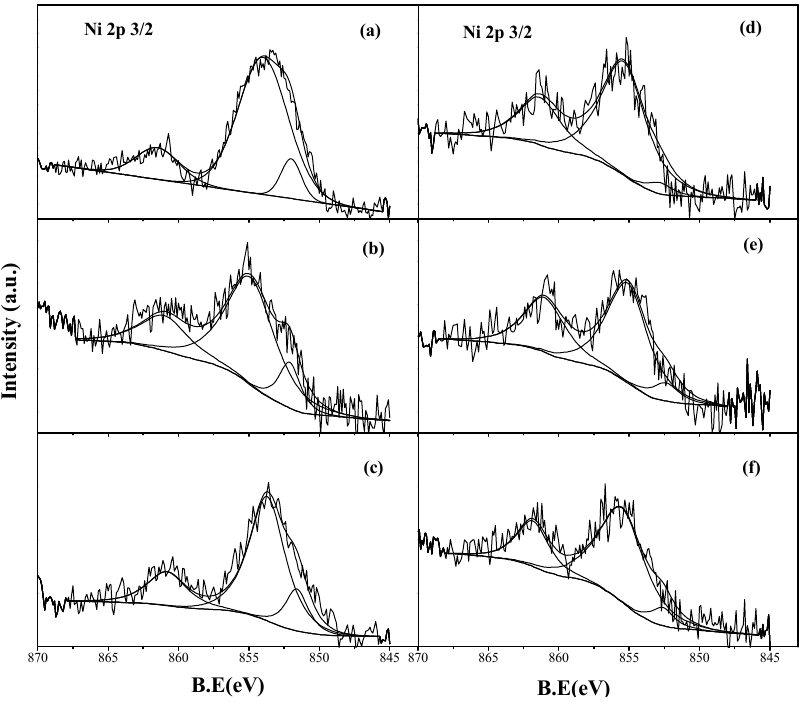
Figure 5. XPS of Ni 2p 3/2 over the reduced catalysts ( a ) MNC 0.8 F 0.0 ; ( b ) MNC 0.5 F 0.3 and ( c ) MNC 0.0 F 0.8 ; and spent catalysts of ( d ) MNC 0.8 F 0.0 ; ( e ) MNC 0.5 F 0.3 ; and ( f ) MNC 0.0 F 0.8 . Table 3. The molar percentages of surface Ni/Fe species over the Ni-based catalysts from XPS. MNC 0.8 F 0.0 MNC 0.5 F 0.3 MNC 0.0 F 0.8 Species Reduced Spent Reduced Spent Reduced Spent Ni 0 /(Ni 0v + Ni 2+ )/% 9.0 3.7 12.5 8.8 14.1 6.7 Fe 0 /(Fe 0 + Fe 2+ + Fe 3+ )/% N.A. N.A. 70.9 12.9 77.6 4.6